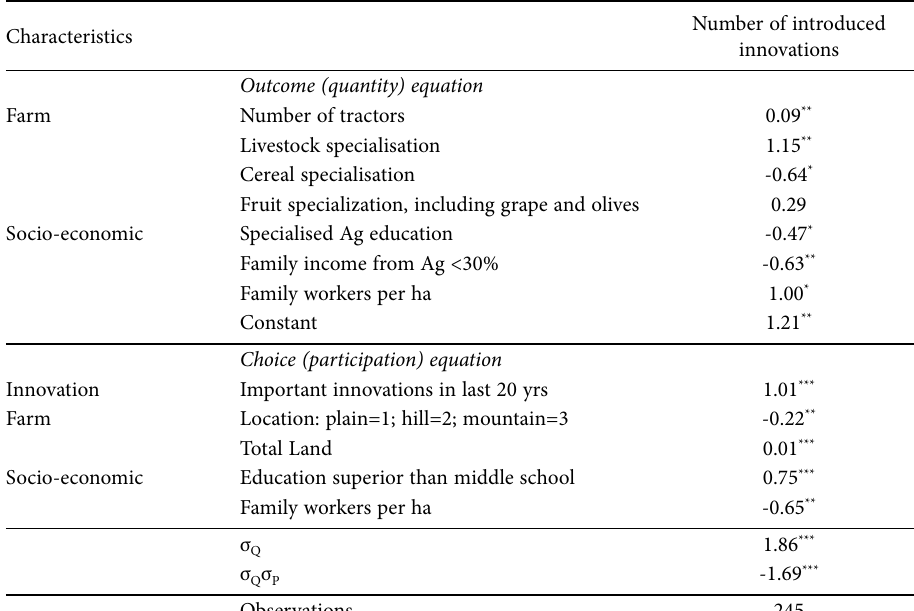
Table 7. Double-Hurdle